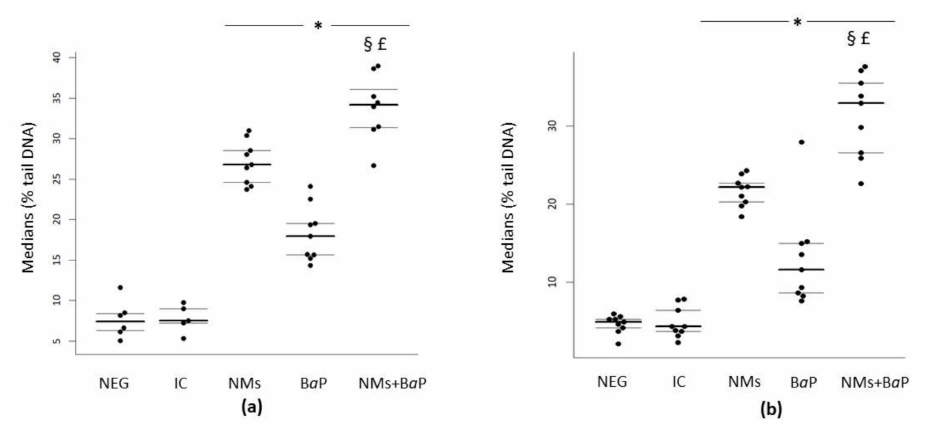
Figure 1. Evaluation of DNA damage using the comet assay following in vitro exposure of human ( a ) and rat sperm ( b ) to NMs+B a P. Tested concentrations: Negative control = Figure 1. S9 mix, 1% DMSO), NMs: aged CeO 2 NMs at 1 µ g · L − 1 ; B a P: B a P at 1.13 µ mol · L − 1 ; NMs+B a P: aged CeO 2 NMs at 1 µ g · L − 1 previously incubated with 1.13 µ mol · L − 1 B a P. p < 0.05, for differences compared versus *: negative control (NEG); §: vs. NMs, £: vs. B a P. Table 1. Median values of the % tail DNA of each condition of three experiments, with 1st and 3rd quartiles, in rat and human sperm. Rat